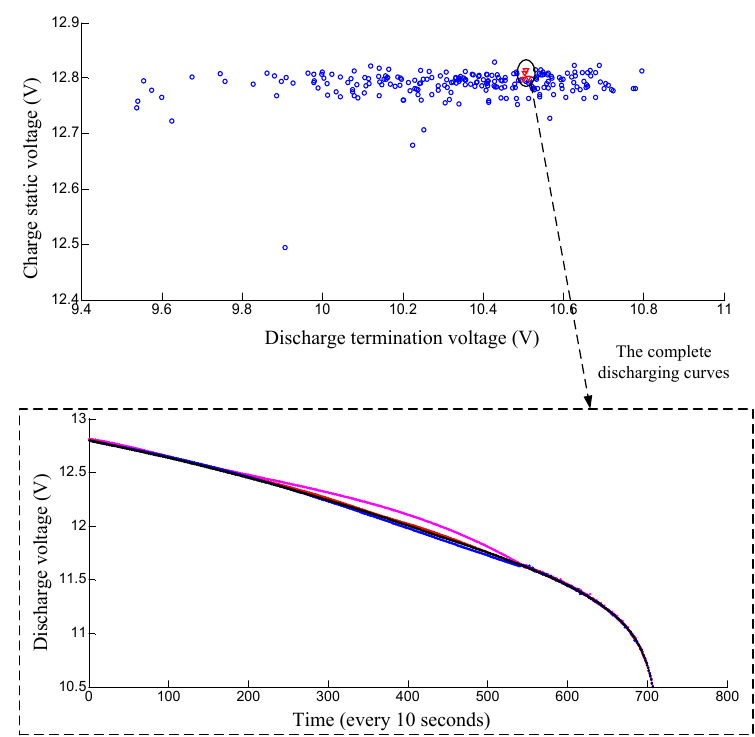
Figure 6. Another successful-grouping battery pack only using the charge static voltage and discharge termination voltage. Note that the discharge curves of this battery pack also have big differences.